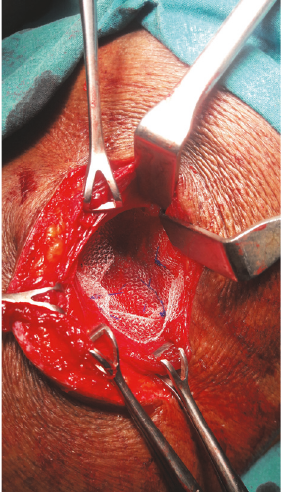
Figure 5: Mesh placed over the sutured fascial flaps and underneath the muscle layer (Sublay).